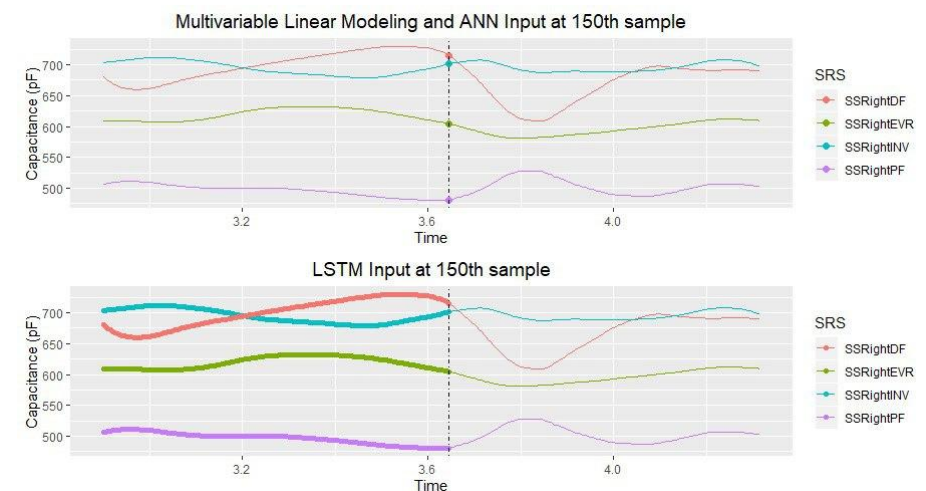
Figure 4. Multivariable linear regression, ANN, and LSTM methods’ approaches in using samples of dataset during training phase. (SRS = soft robotics sensors).